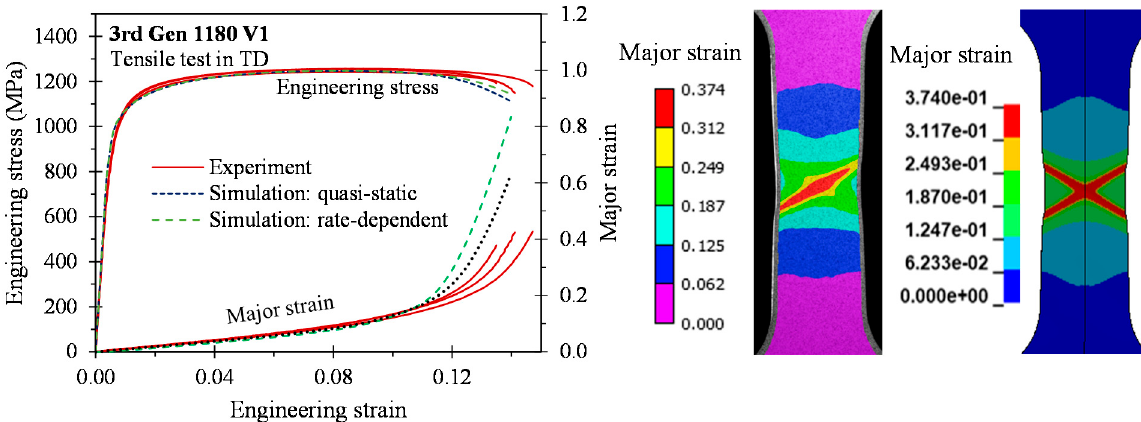
Figure 17. Comparison of the global and local response in 3D tensile simulations for the 3rd Gen 1180 V1.